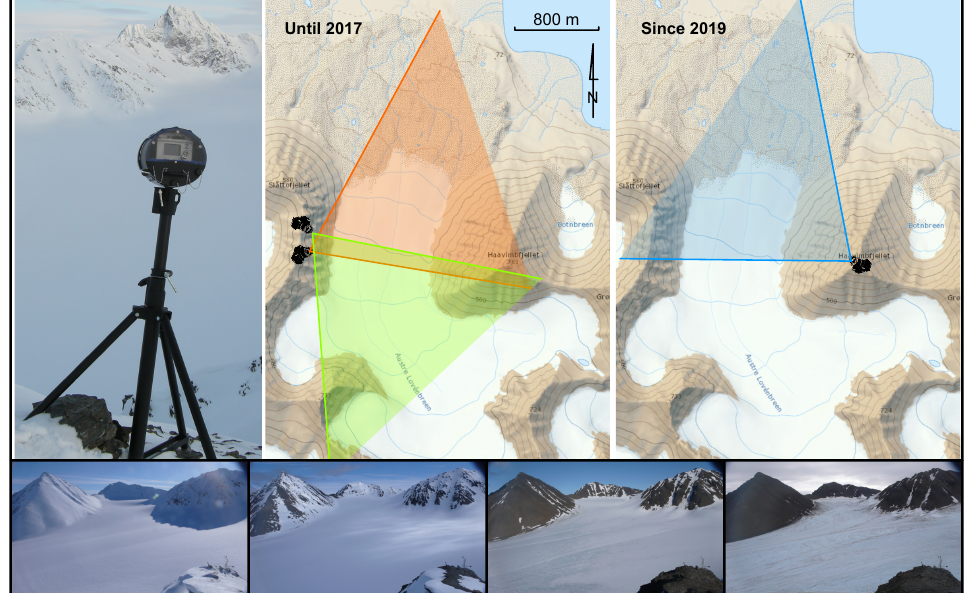
Figure 2. Top-left : automated digital cameras have been installed around the glacier basin for contin- uous, year-long observation of the snowpack and deducing the FSC from digital image processing. Top-middle and -right : area covered by two cameras until 2017; in 2019, a new camera was setup at the top of the highest summit in order to observe both the glacier snout and the proglacial area. These data are analyzed in this paper. Bottom : sample images from the 2017 position (green viewshed) emphasizing the challenge of azimuthal projection of the oblique-view pictures despite the camera being located on one of the most elevated points of the basin, and differentiating ice and snow covered areas under natural